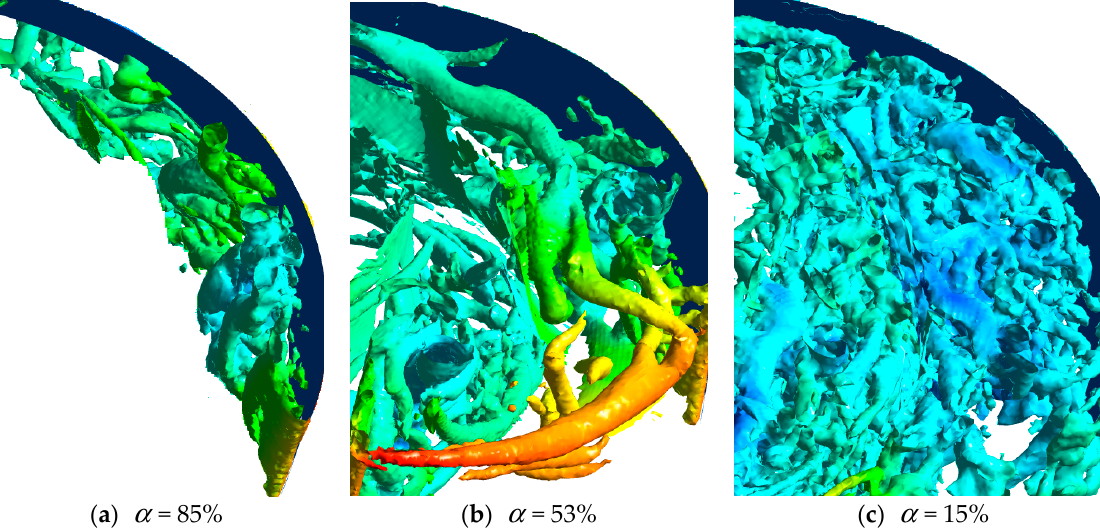
Figure 9. Vortex structures in different inlet attack angles (10% characteristic scale).